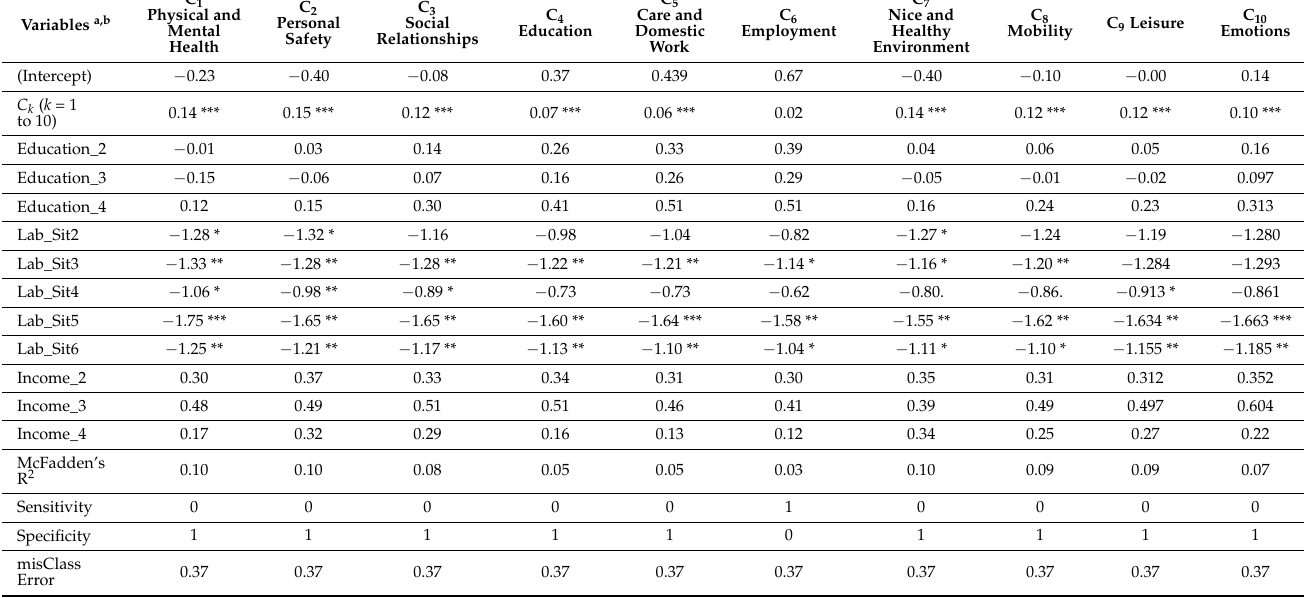
Table A2. Significance of coefficients of regressions with different capabilities. Men.